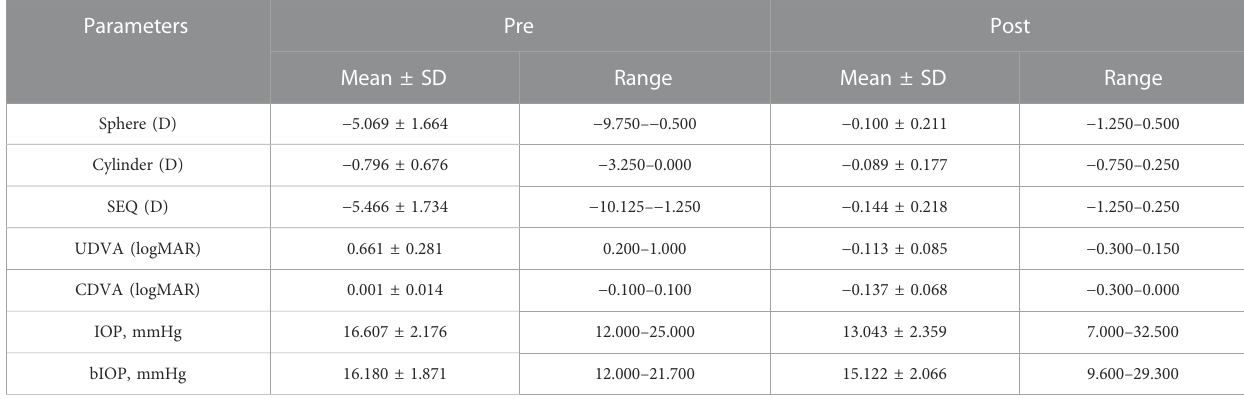
TABLE 1 Ocular biological parameters before and after small incision lenticule extraction